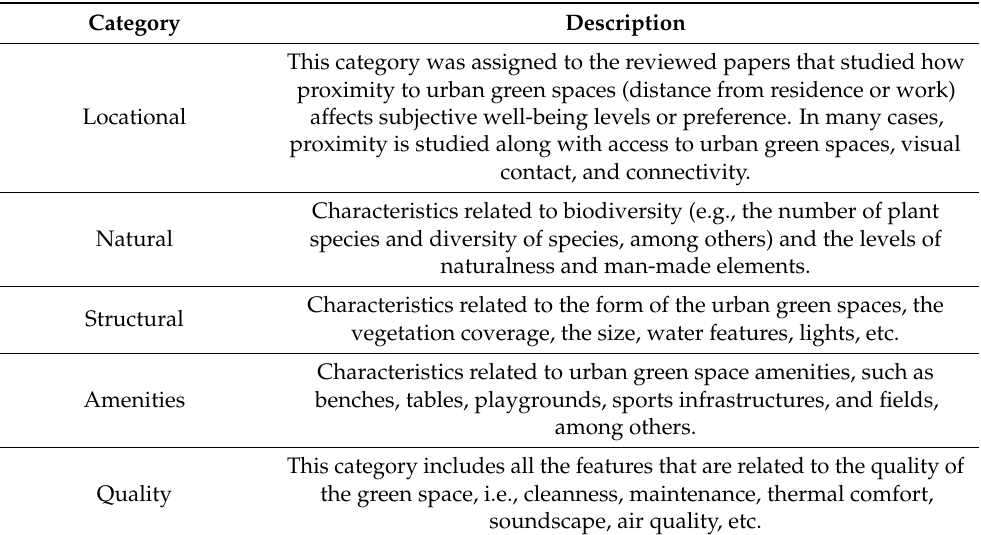
Table 2. Categories of Urban Green Space